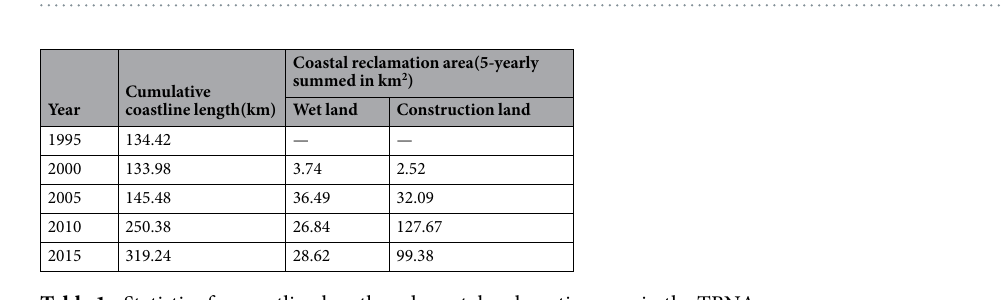
Table 1. Statistics for coastline length and coastal reclamation area in the